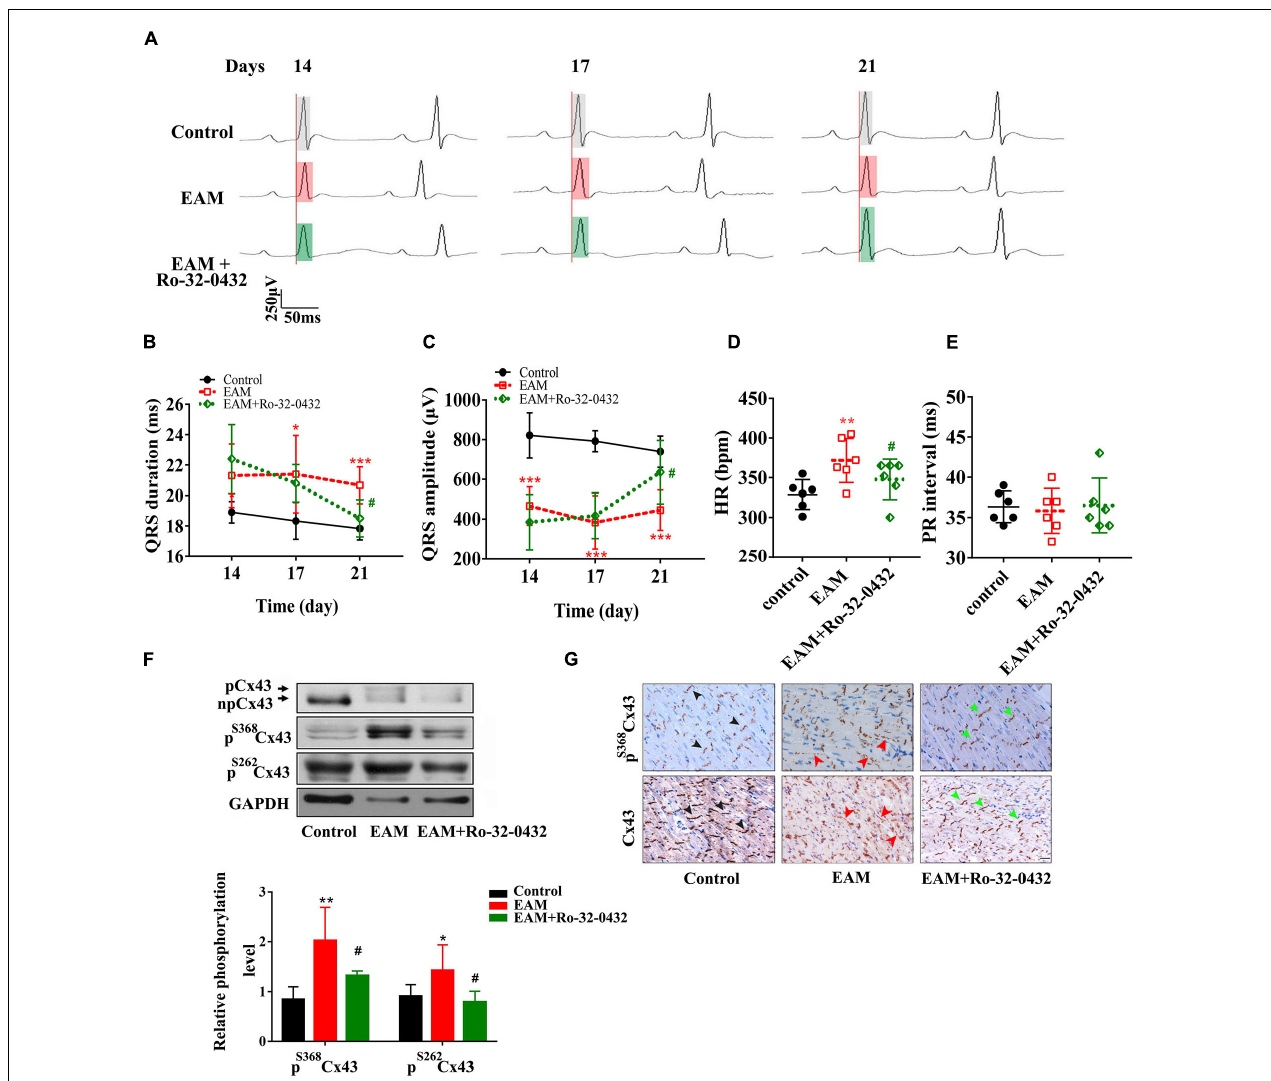
FIGURE 4 | Blockade of protein kinase C (PKC) with Ro-32-0432 prevented the prolonged duration and low voltage of the QRS complex by suppressing Cx43 hyperphosphorylation and redistribution. (A) Representative ECG recording of normal, experimental autoimmune myocarditis (EAM), and Ro-32-0432-treated EAM rats. Each set of the ECG was recorded from the same rat on days 14, 17, and 21. Light gray box: QRS duration of control rats; light red box: QRS duration of EAM rats; light green box: QRS duration of Ro-32-0432-treated EAM rats. (B–E) Statistical data of ECG, QRS duration (B) , QRS amplitude (C) , HR (D) , and PR interval (E) . (F) Western blot images of pS368Cx43, pS262Cx43, and Cx43 in the cardiac ventricles of control, EAM, and Ro-32-0432-treated EAM rats. n = 6 for each group. (G) Immunohistochemical analysis of Cx43 and pS368Cx43 expression and redistribution (Bar = 20 µ m). The black arrows in the pictures of the control group indicate the normal pattern of Cx43 and pS368Cx43 in intercalated disc; the red arrows indicate the lateralization of Cx43 and pS368Cx43 in the EAM group; the green arrows indicate partially recovered pattern and distribution of Cx43 and pS368Cx43 in Ro-32-0432-treated EAM group. Error bars represent mean ± SD . * p < 0.05 vs. control; ** p < 0.01 vs. control; *** p < 0.001 vs. control; # p < 0.05 vs.